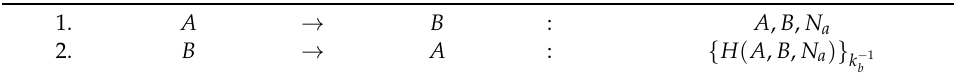
Table 4. challenge–response